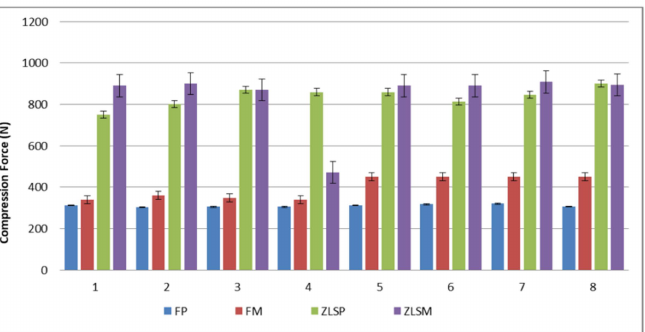
Figure 2. Mean maximal compressive values for the heat-pressed samples FP, ZLSP, and milled FM, ZLSM.